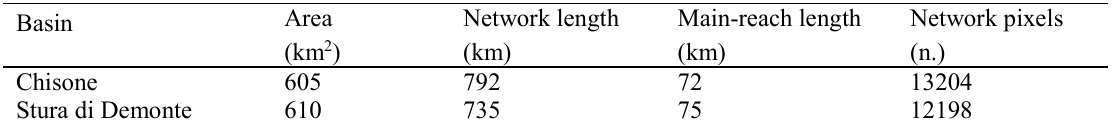
Table 1 Main characteristics of the case study basins.